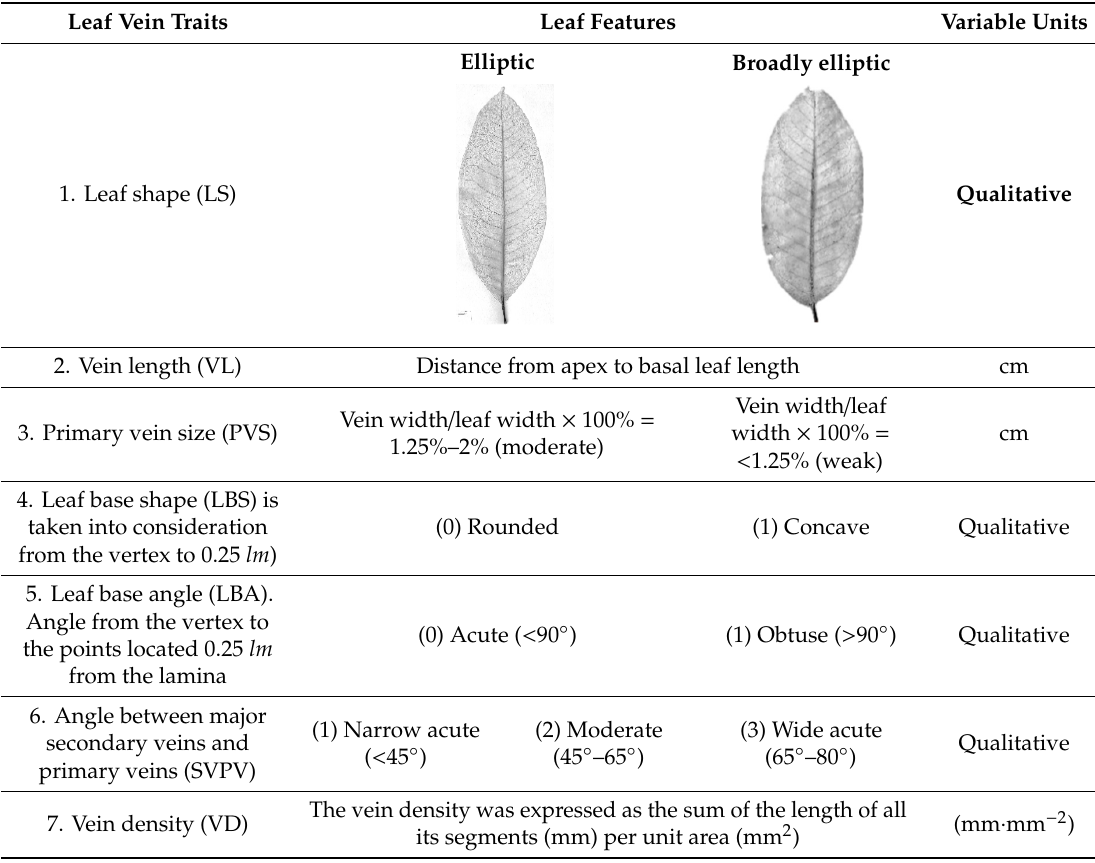
Table 1. List of seven Magnolia schiedeana ’s leaf vein traits with their acronyms and features measured. Leaf Vein Traits